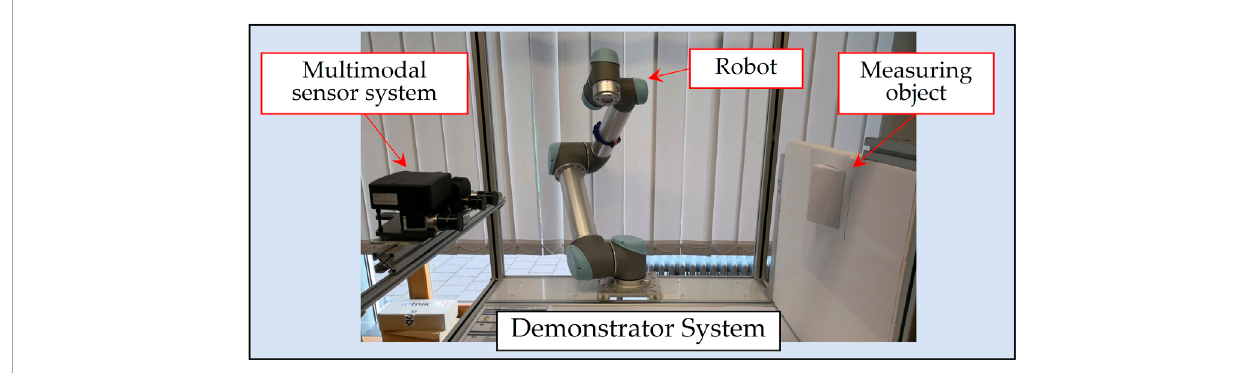
FIGURE 8 Experiment environment and our demonstrator system.